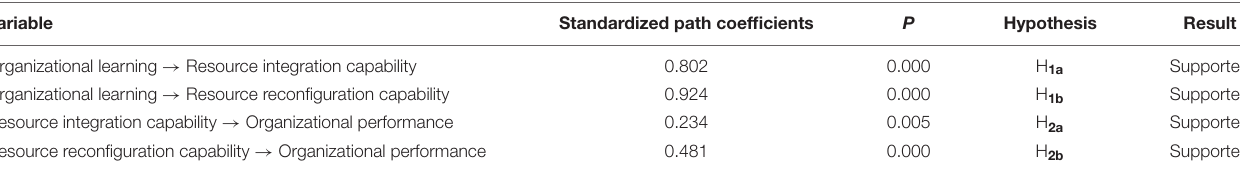
TABLE 9 | Hypothesis test results of path coefficients of structural equation